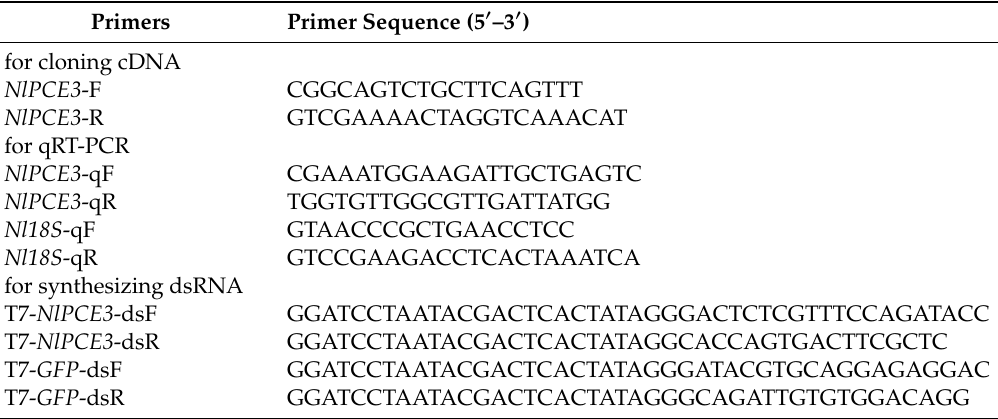
Table 1. The primers used in this